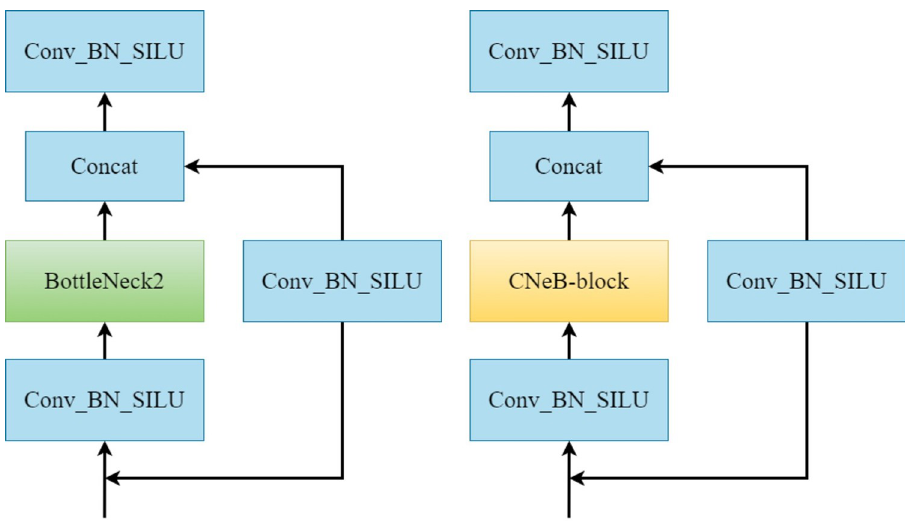
Fig 4. The structure of the C3 module and CNeB module. (a) structure of the C3 module (b) structure of the CNeB module.